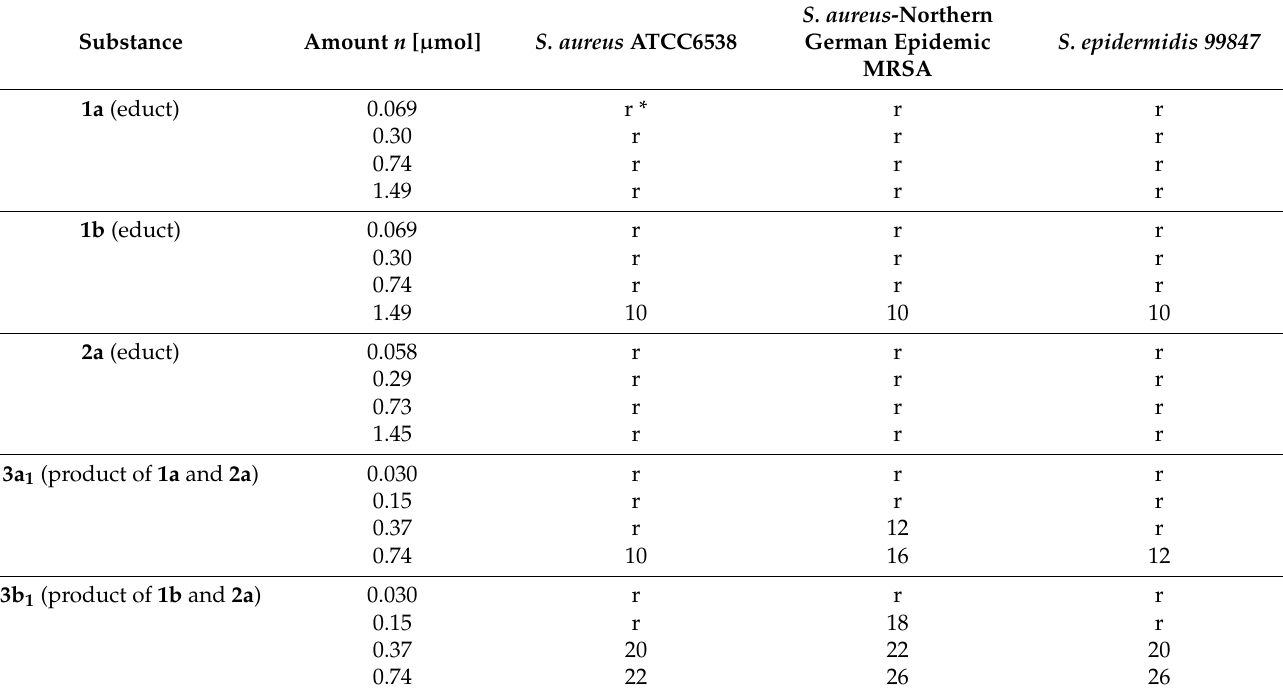
Table 4. Antimicrobial activity of products 3a 1 and 3b 1 , educts 1a to 1b and 2a against different Staphylococcus species; Zones of inhibition are given in diameter [mm] including paper disc (6